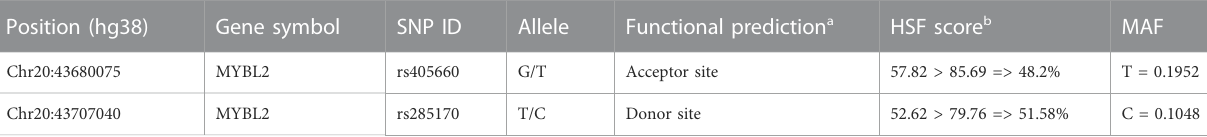
TABLE 1 Outcome of HSF prediction. Position (hg38) Gene symbol SNP ID Allele Functional prediction a